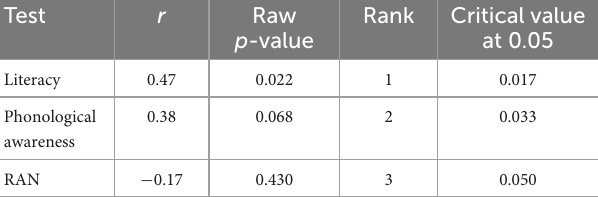
TABLE 3 Correlations in the dyslexia group between the test performance and MMN amplitude change after training with the non-game.